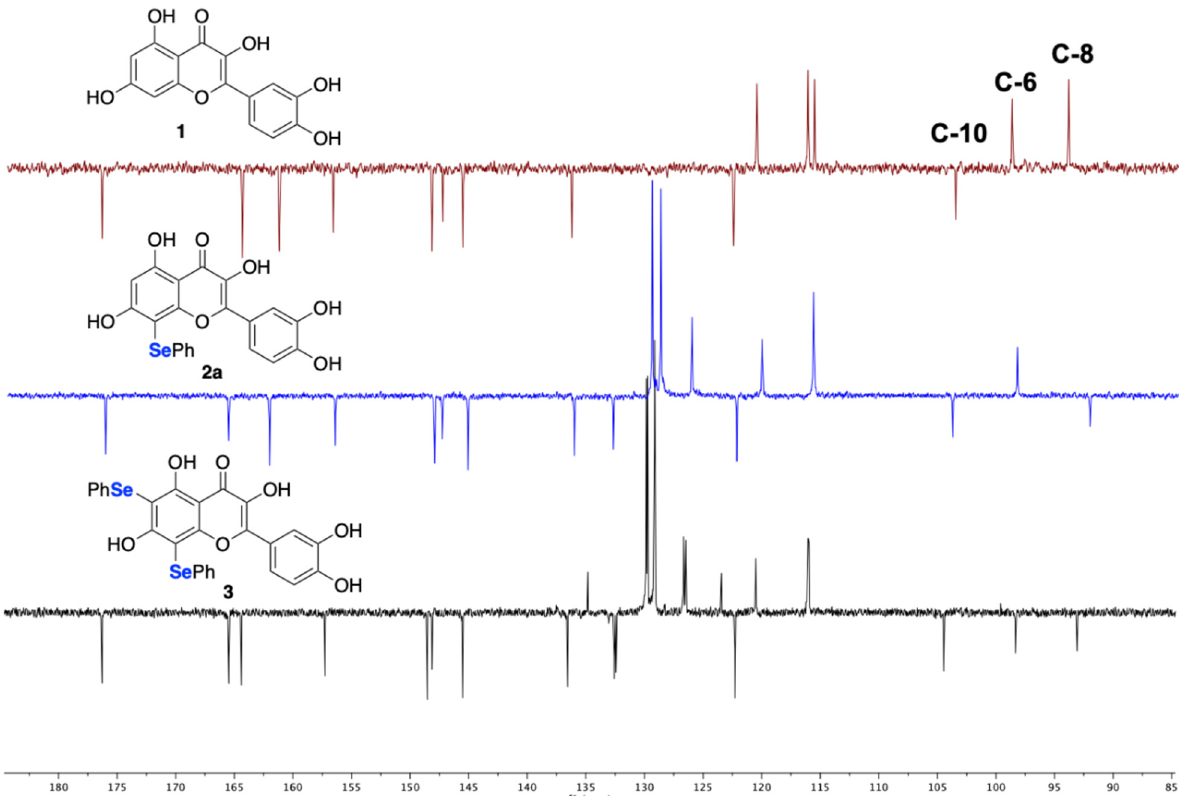
Figure 2. 13 C spectra of 1 , 2a , and 3 recorded using the APT pulse sequence.